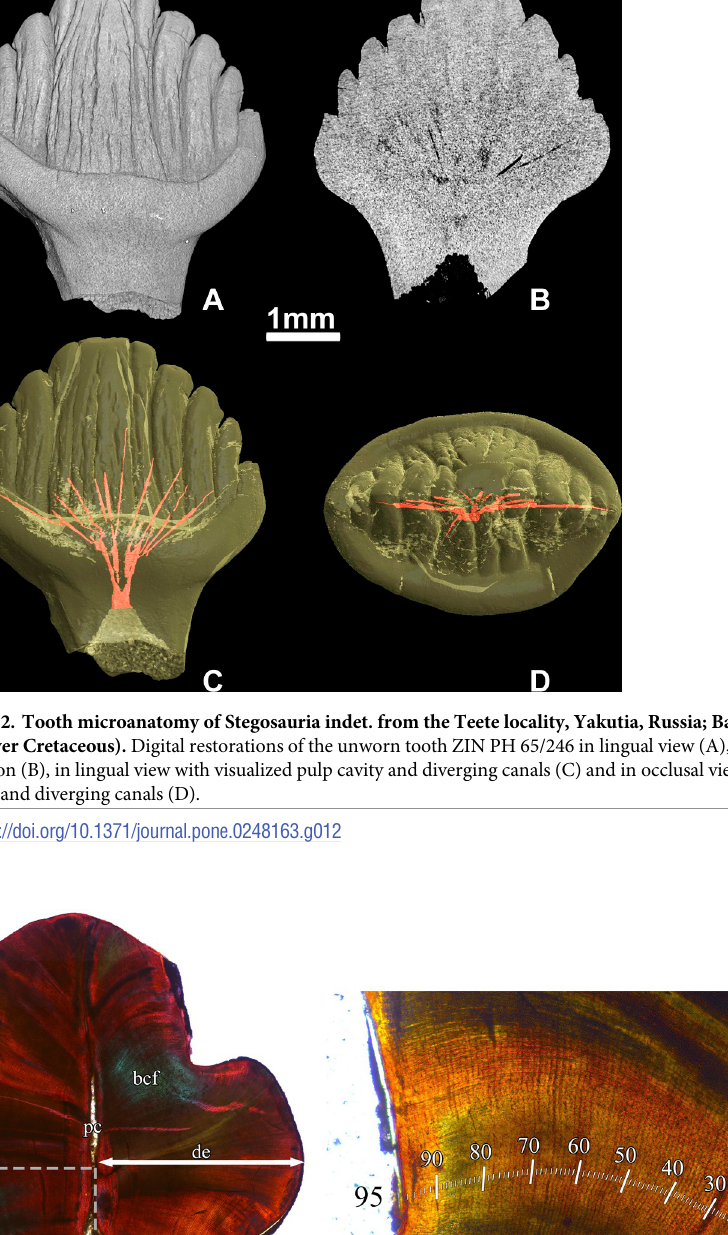
PLOS ONE | https://doi.org/10.1371/journal.pone.0248163 March 17,